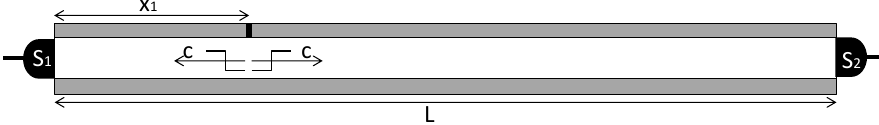
Figure 2. The difference in time-of-arrival of the negative pressure waves at the two pressure sensors mounted at both ends of the tube allows for locating the